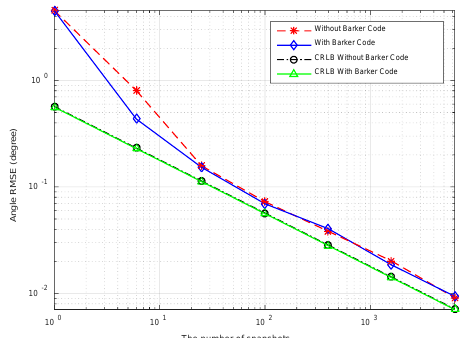
Figure 8. Comparison between CRLB and RMSE versus SNRs.